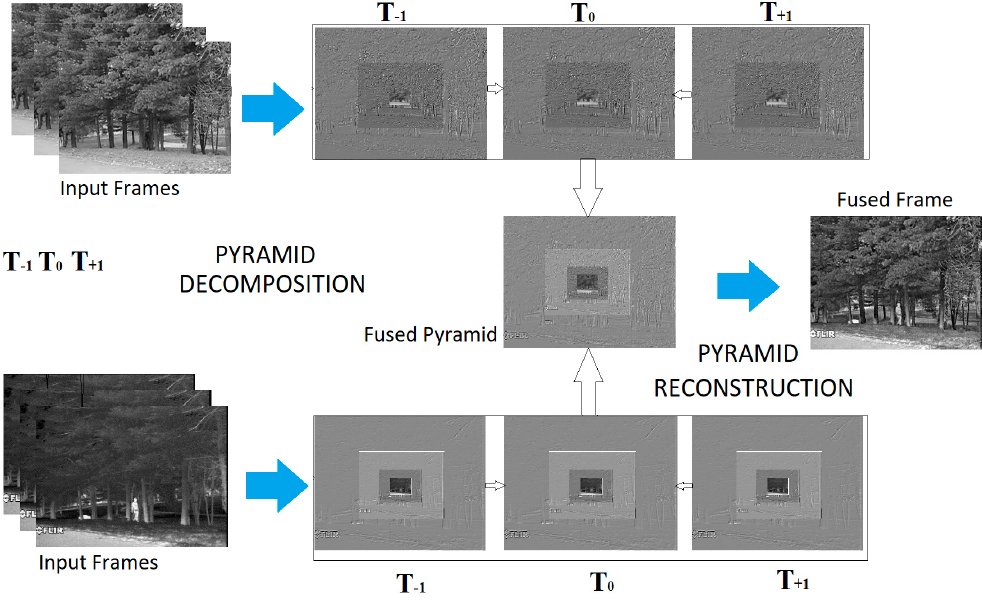
Figure 5. Block diagram of the video fusion method based on spatio-temporal Laplacian pyramid.